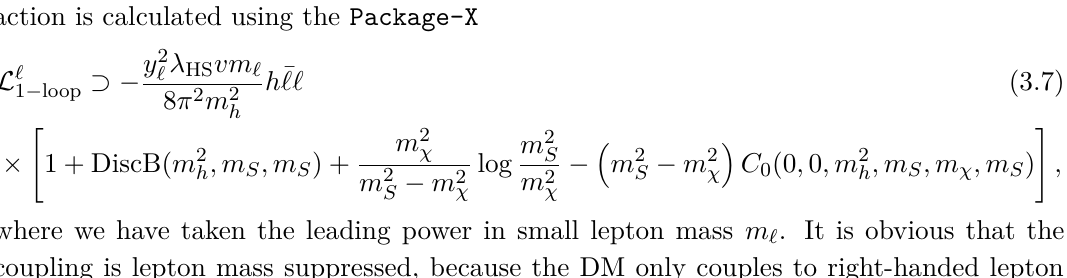
Figure 7 . Left: the Higgs invisible decay as a probe for the combination y 2 Right: the CEPC sensitivity Br ( h → inv) < 0 . 3% can set bounds on λ the relic abundance